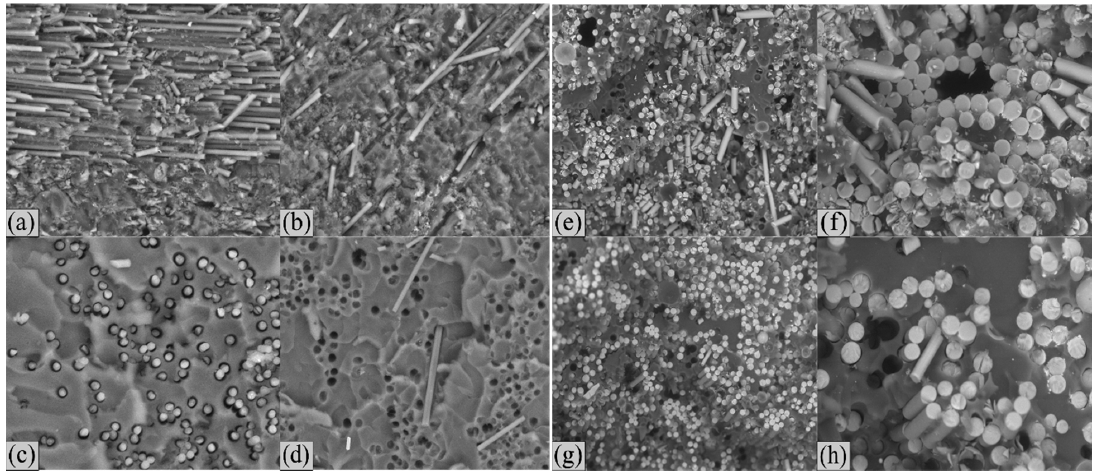
Figure 9. SEM images of ( a – d ) rCF/EP composites and ( e – h ) rGF/EP composites after tensile testing.